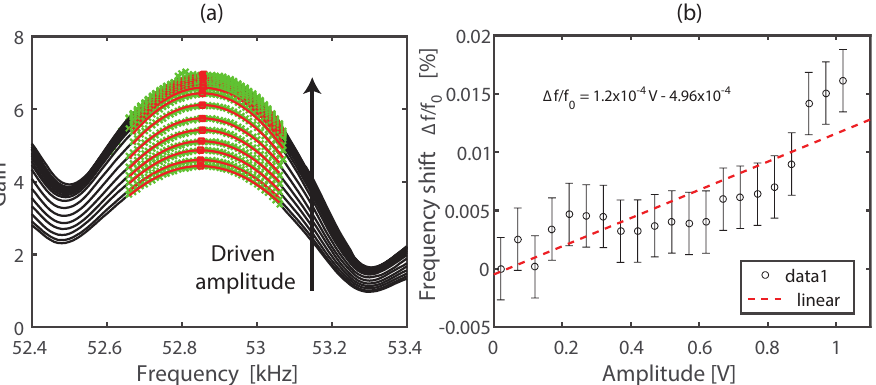
Figure 5. NRUS results. ( a ) Gain spectre for incremental levels of the driven amplitude. The red curve represents the second order polynomial fit around the gain peak (red colour data). ( b ) Frequency-shift in function of the driven amplitude and estimation of the nonlinear hysteretic parameter α . Error bars on ( b ) were estimated from the fitting